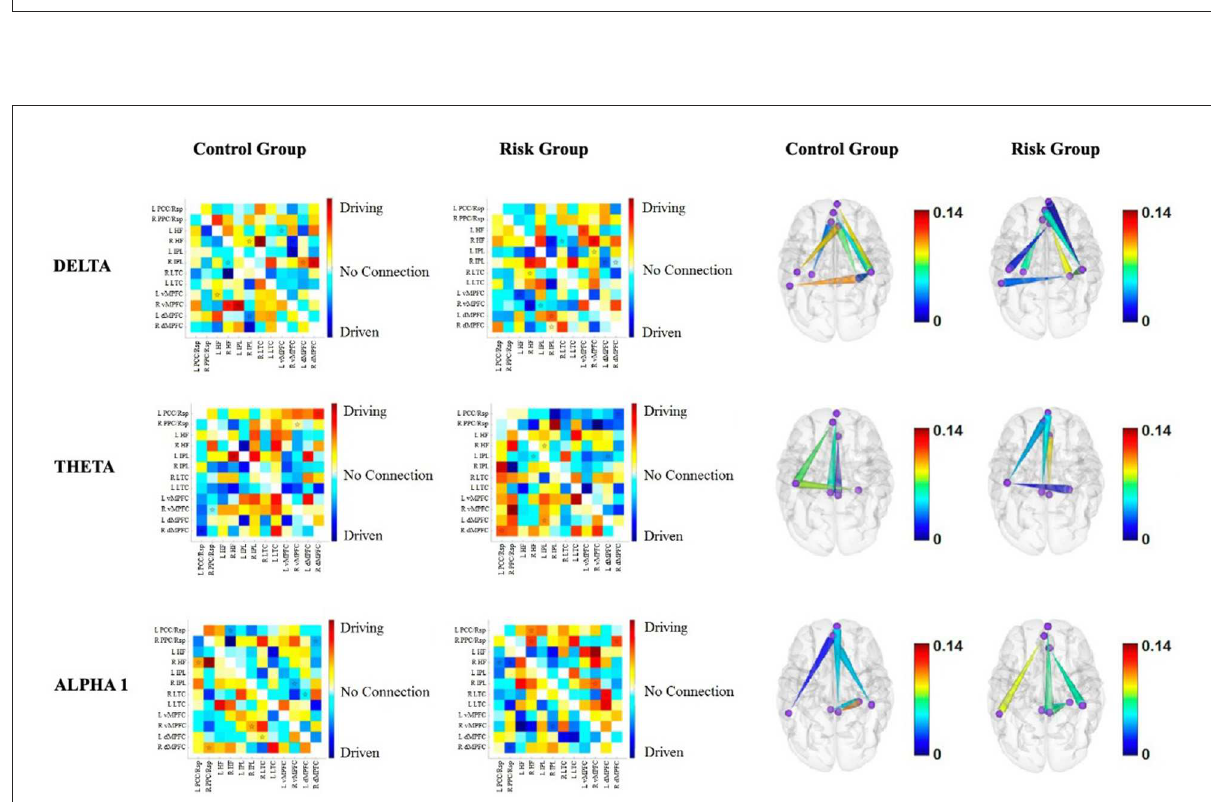
FIGURE4 Functional connectivity between the nodes of the DMN for each group for delta, theta and alpha1. The first two columns correspond to the functional connectivity matrices of the CG and the RG, respectively. Warm colors indicate the driving nodes, and cool colors indicate the driven nodes. The connections that exceeded the probability threshold ( p = 0.05) are indicated with a star and are shown in the cortical maps of the last two columns. Direction is represented by the cones, with the vertices indicating the driven nodes and the bases indicating the driver nodes. The color scale illustrates the connectivity strength. The rows represent each frequency